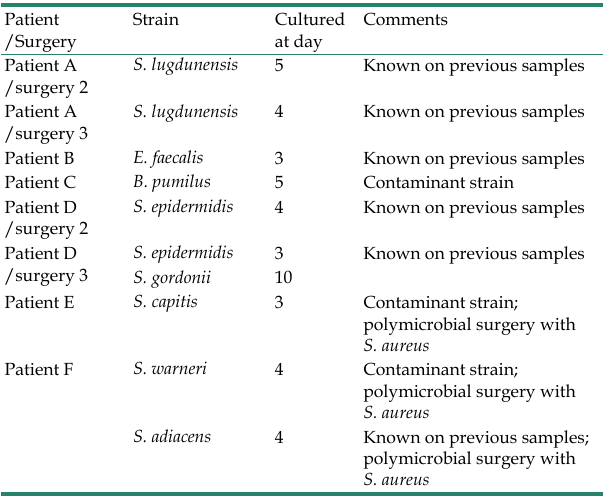
Table 4. Strains detected from D3 ( C. acnes and C. avidum excluded)